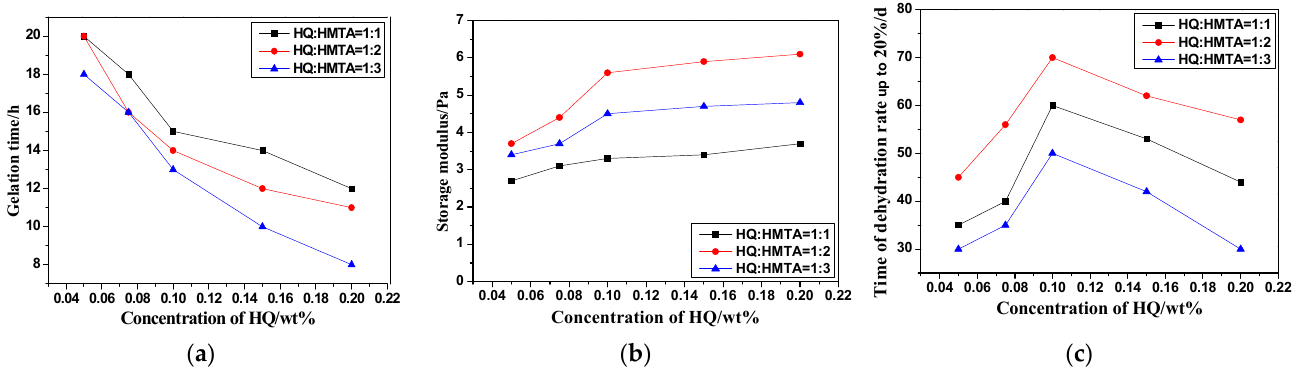
Figure 3. Effect of cross-linking agent with different proportions on gel properties. ( a ) Effect of cross-linking agent with different proportions on gelation time; ( b ) Effect of cross-linking agent with different proportions on gel strength; ( c ) Effect of cross-linking agent with different proportions on long-term stability.